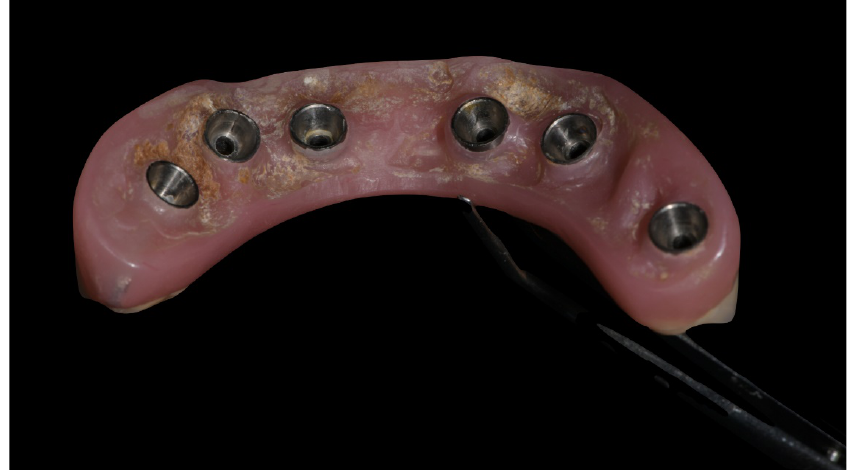
Figure 2. Pictures of detachments of tooth parts and pink resin from the prosthetic restoration.